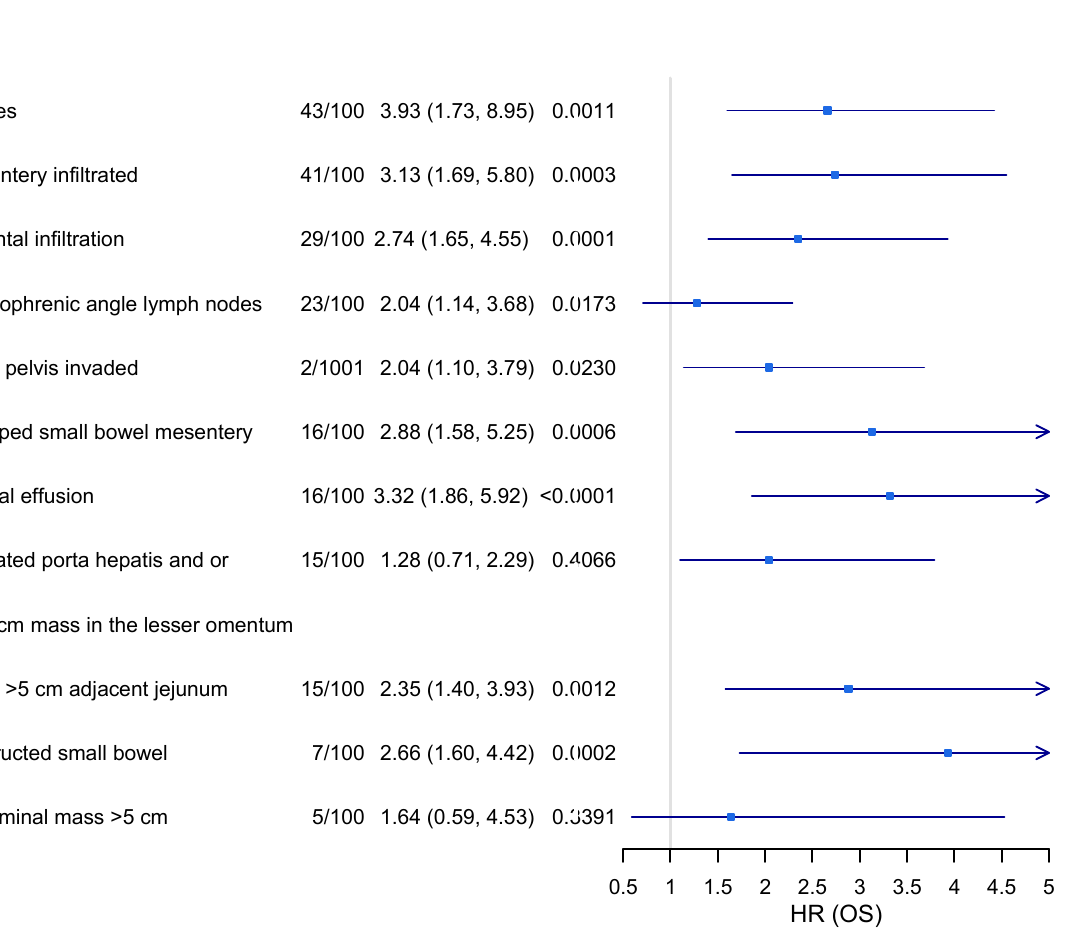
Figure 2. Prognostic significance of radiological features evaluated by preoperative chest abdominal CT scan in DMPM patients. n/N: incidence of feature in 100 DMPM cases. Laterza et al. reported using preoperative laparoscopy in 33 DMPM patients who